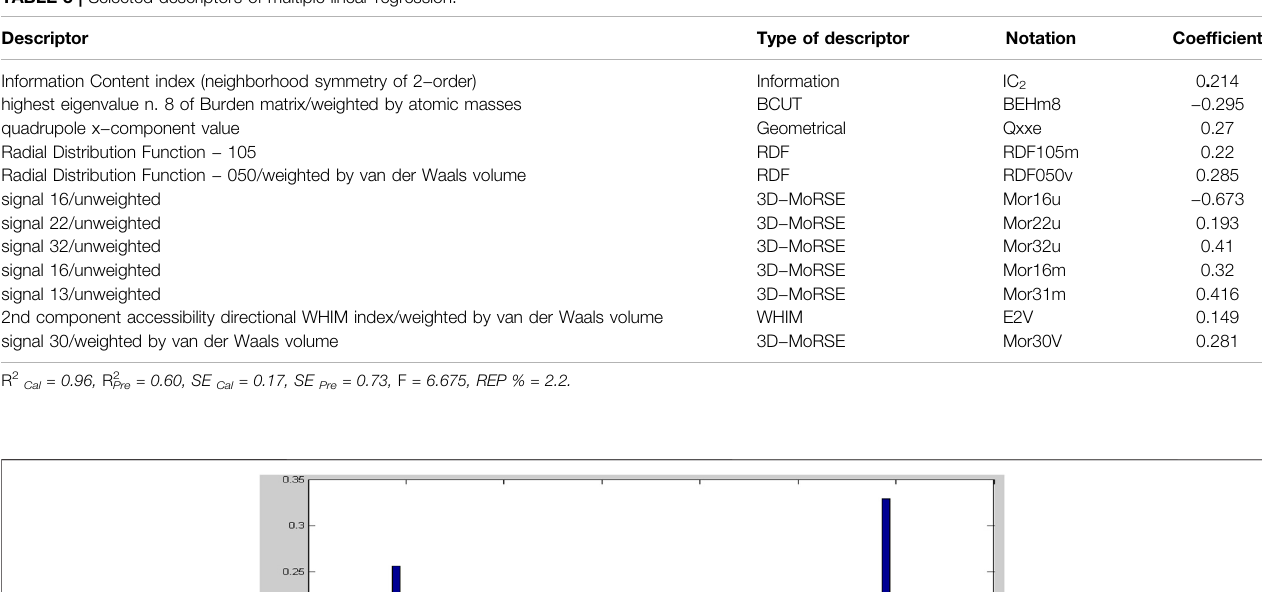
TABLE 3 | Selected descriptors of multiple linear regression.